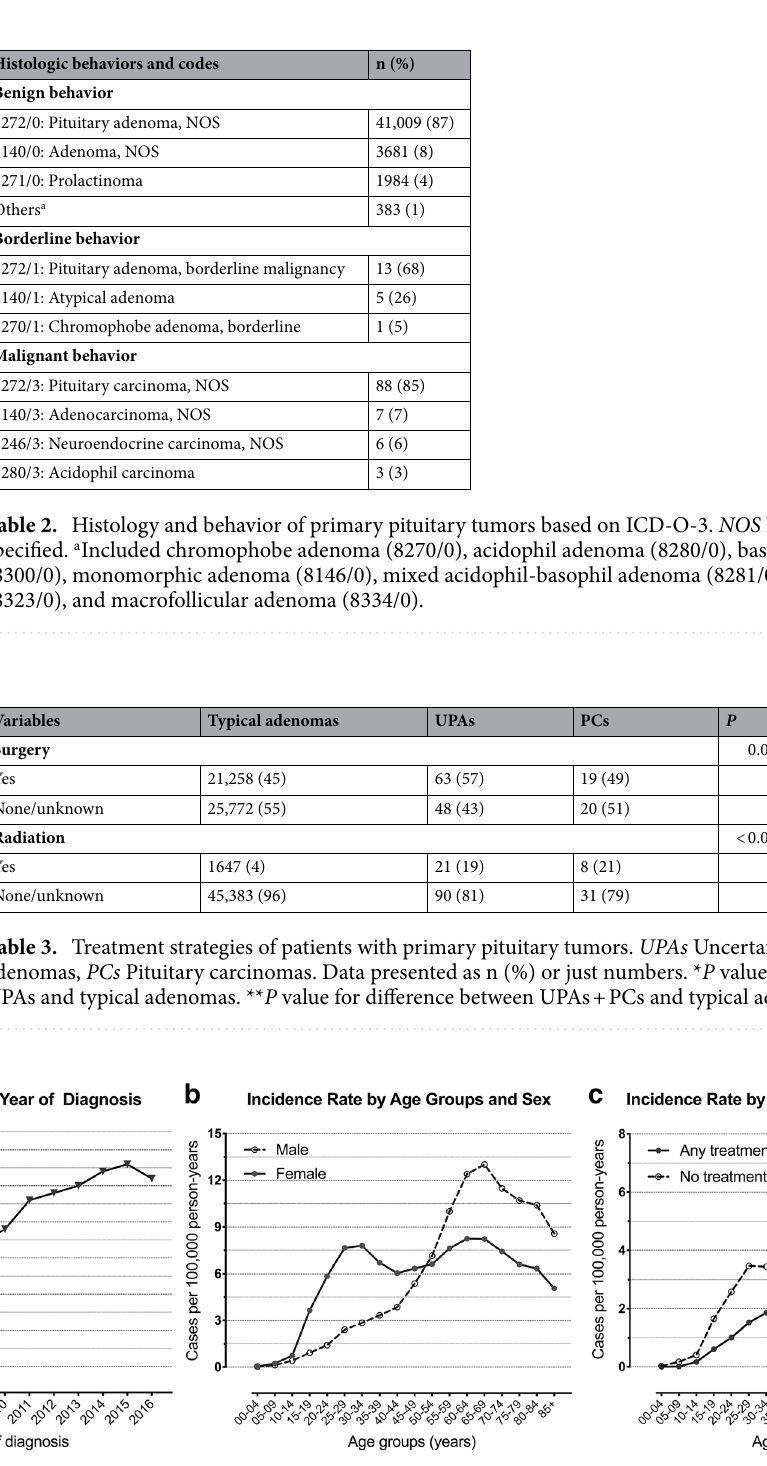
Figure 1. Standardized incidence rate of primary pituitary adenoma by ( a ) year of diagnosis, ( b ) age/sex groups and ( c ) age/treatment groups. Reference population is the general US population or the population in corresponding